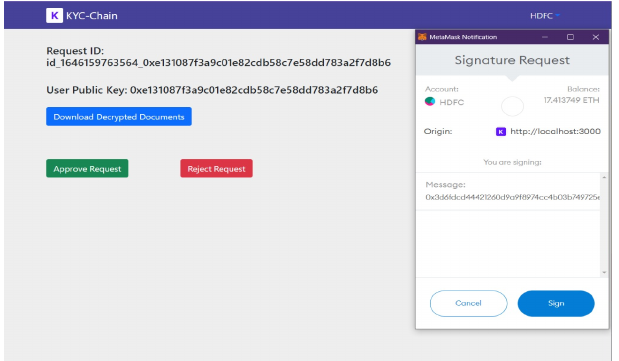
Fig. 7. Organization’s view of processing client requests Fig. 4 . KYC Verification process for registered client